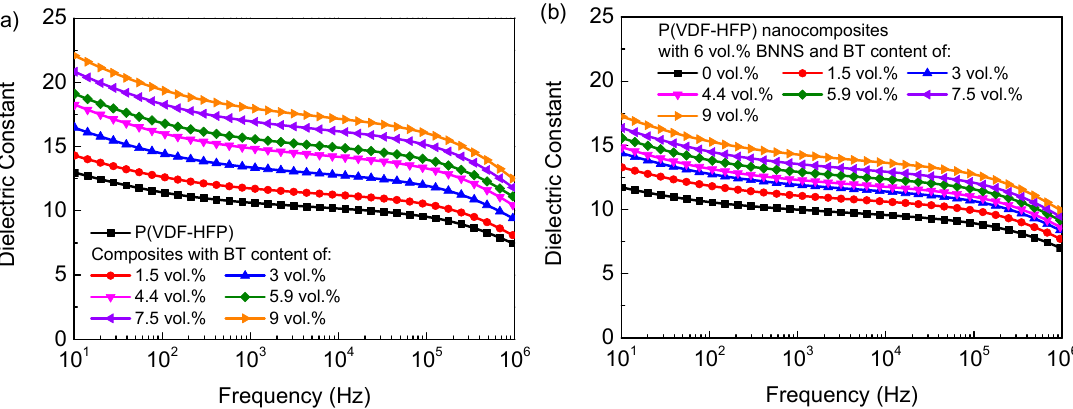
Figure 3. Frequency-dependent dielectric constant of ( a ) the P(VDF-HFP)/BT nanocomposites and ( b ) the ternary nanocomposites with 6 vol.% BNNSs.